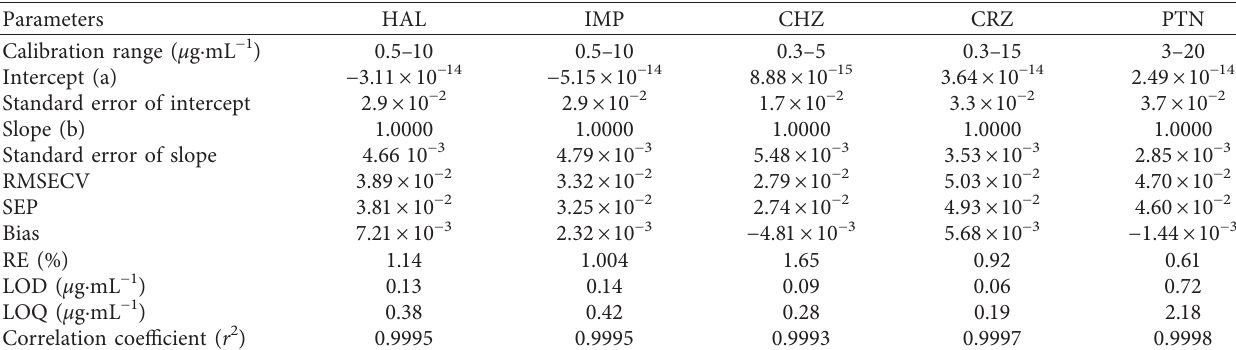
Standard error of